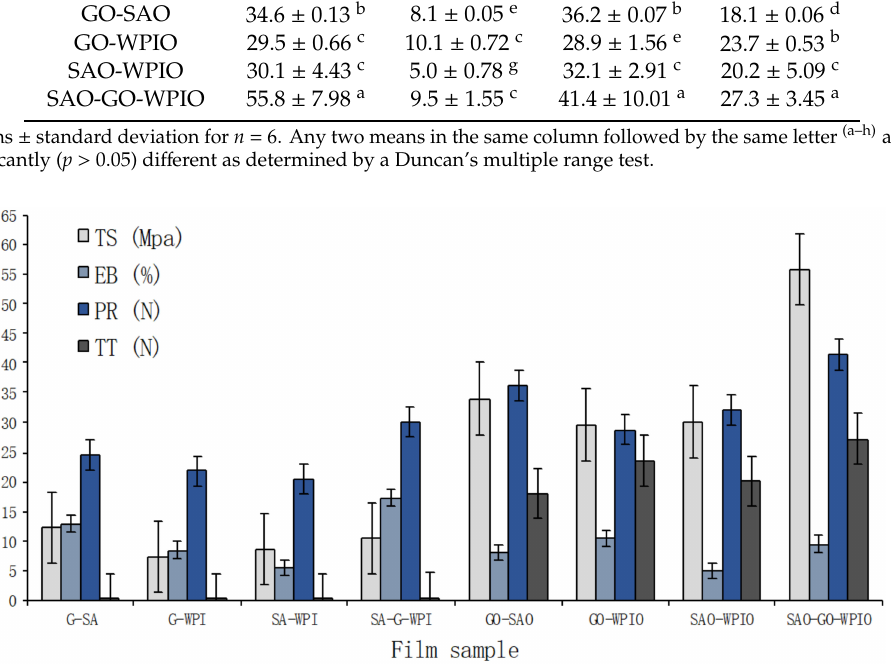
Figure 1. Values for tensile strength (TS), elongation at break point (EB), puncture resistance (PR) and tear strength (TT) of laminated films. Means ± standard deviation for n =